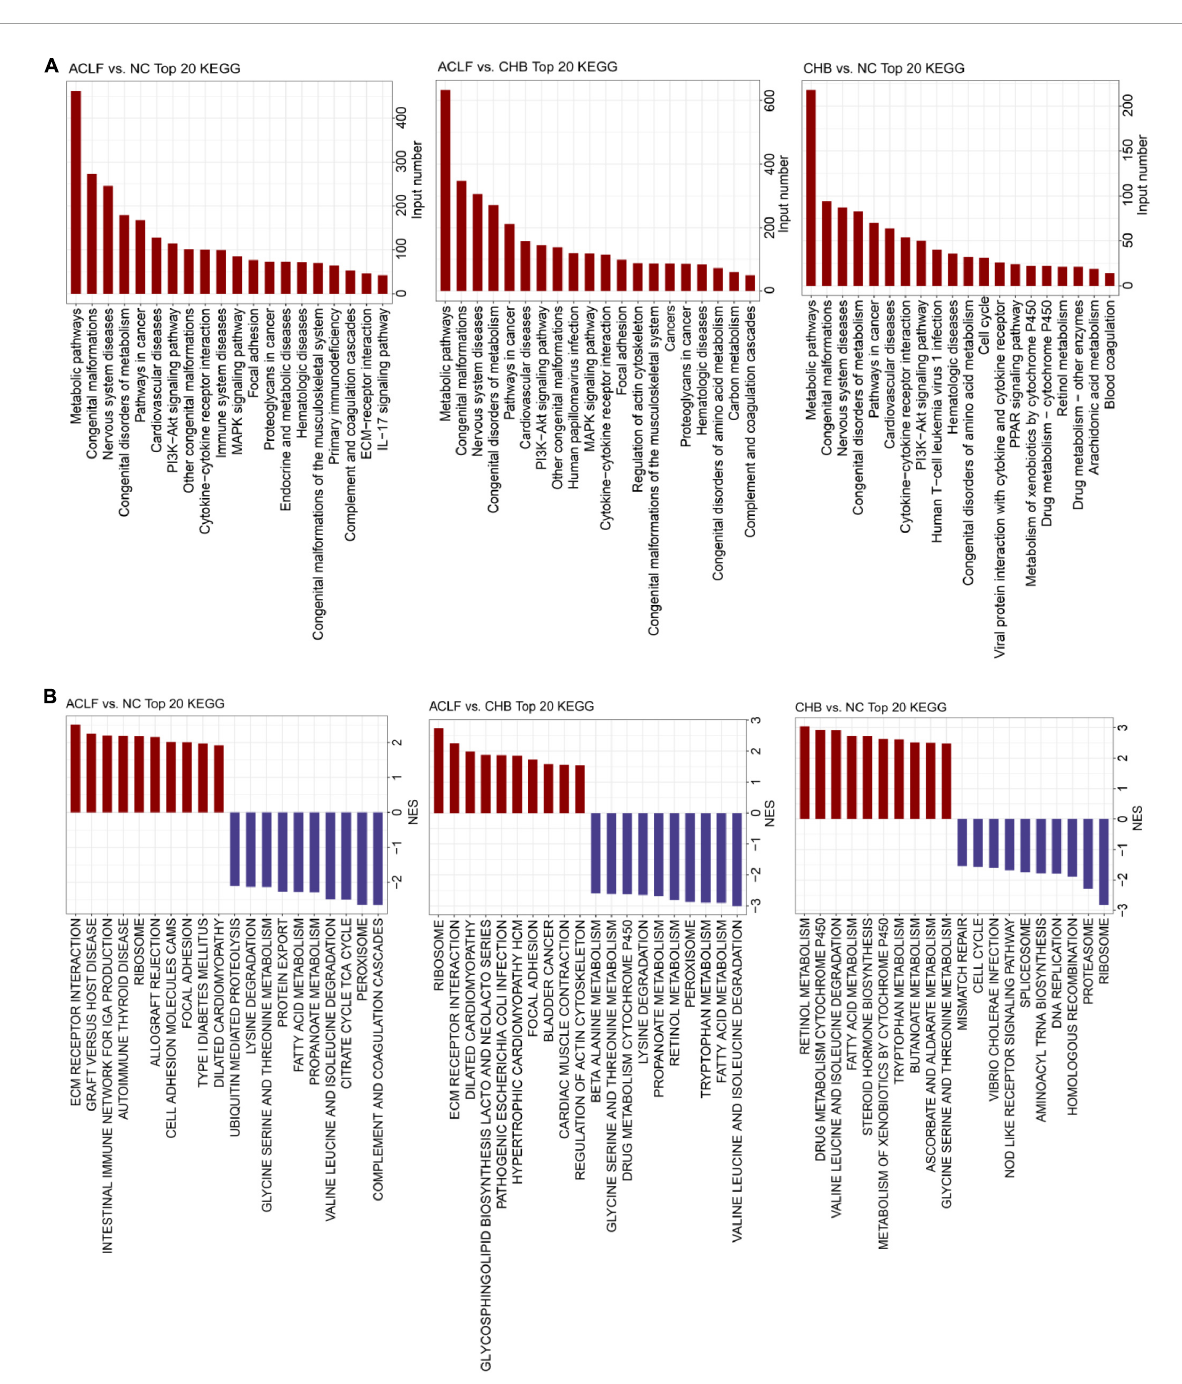
signaling pathway, dilated cardiomyopathy, chemokine signaling pathway, purine metabolism gnrh signaling pathway, estrogen signaling pathway and congenital malformations